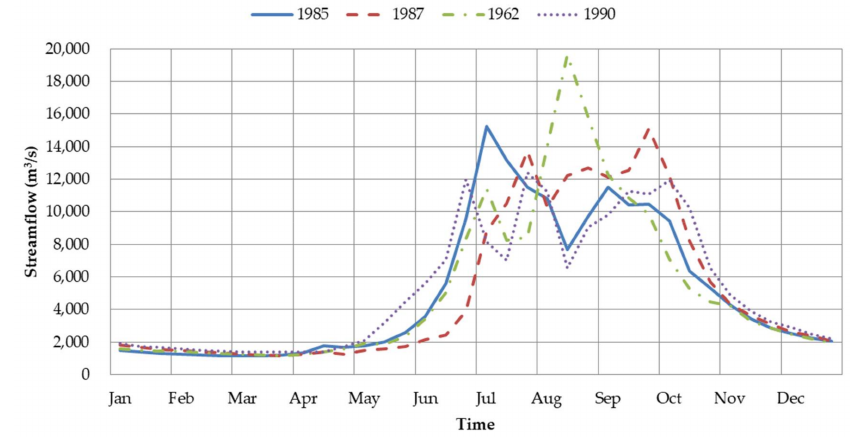
Figure 6. Streamflow of Pingshan station in wet years.